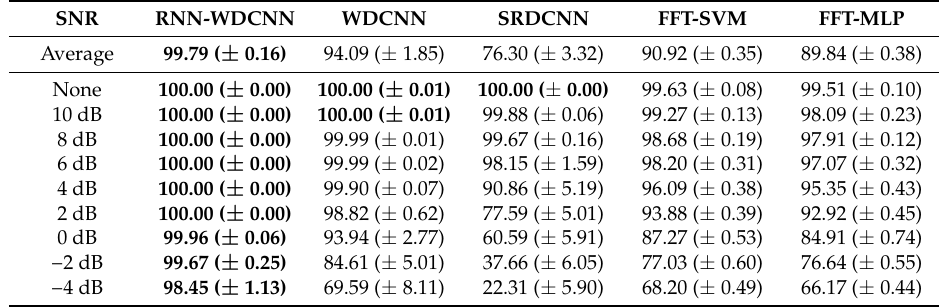
Table 14. Recall scores of the models considered in this work (as a percentage) for noise rejection performance (best values are highlighted in bold).